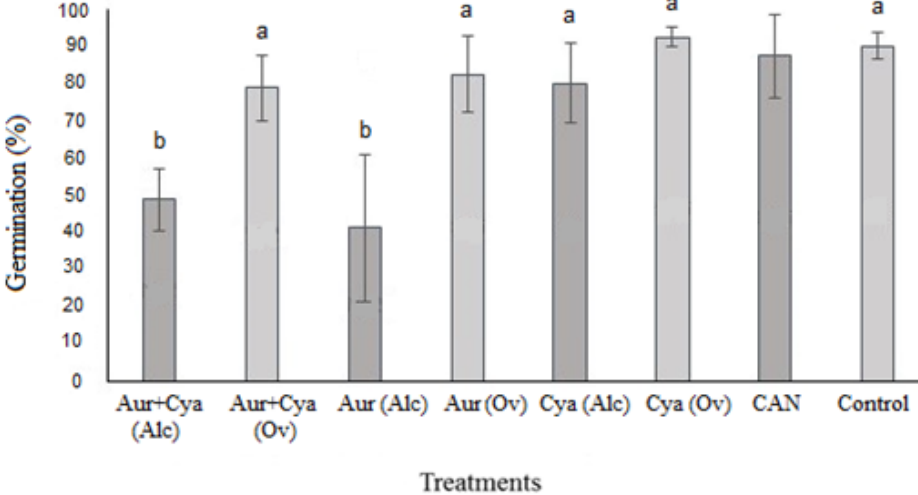
Figure 1. Total germination in percent depending on the di ff erent treatment applications in the petri plate experiment. The error bars represent the ± standard deviation. Welch test in two pairs only with control. Same letters indicate no significant differences with control.